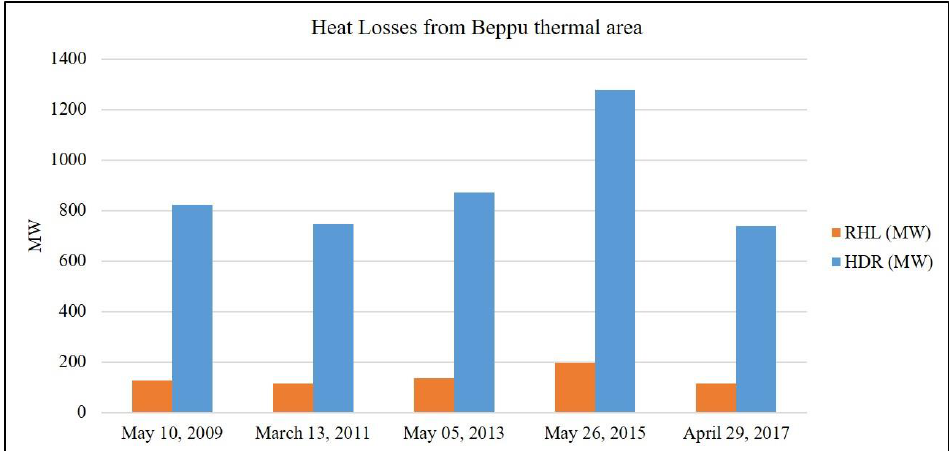
Figure 16. Changes in total radiative heat loss and heat discharge in the Beppu geothermal area from 2009 to 2017.